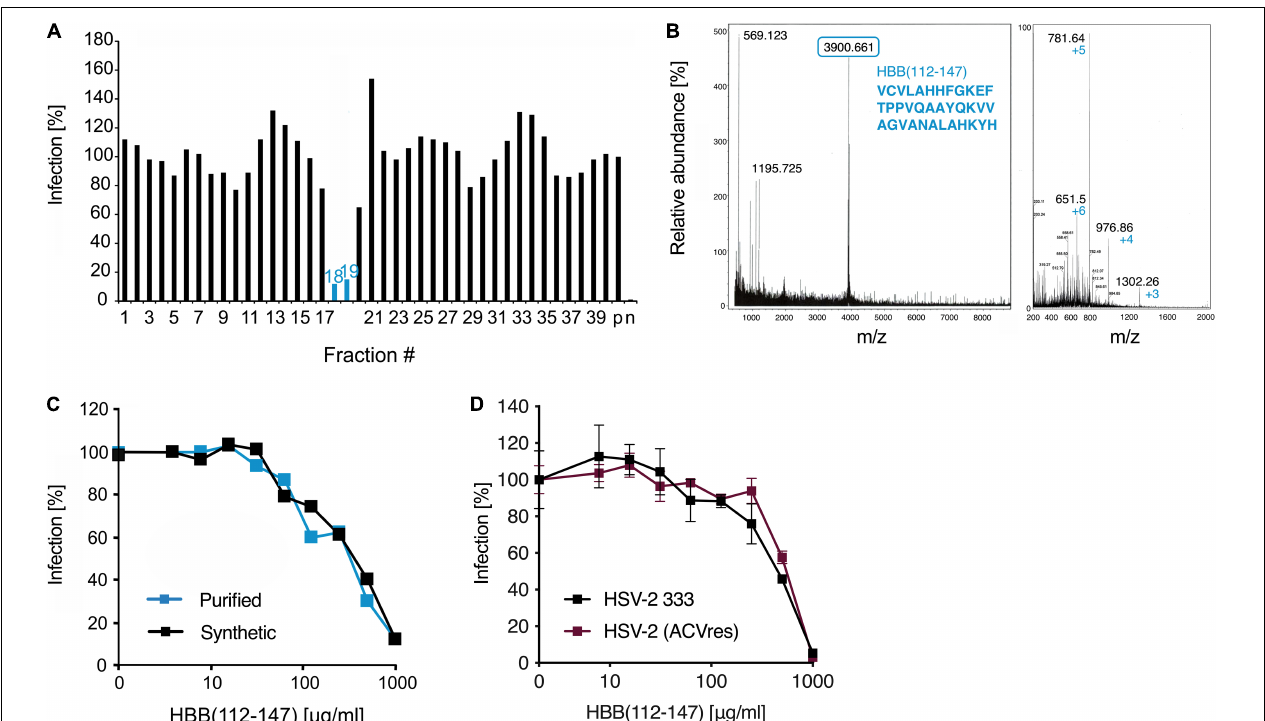
FIGURE 1 | Identification of a C-terminal fragment of hemoglobin as HSV-2 inhibitor in a placenta-derived peptide library. (A) Fractions 1–39 of pH pool 4 of the placenta library were added to ELVIS cells and subsequently infected with HSV-2. Infection rates were determined 2 days later by quantifying β -galactosidase activities in cellular lysates. (B) MALDI-MS (left) and ESI-MS (right) spectra of fraction 19. The peaks correspond to HBB(112–147). (C) HBB(112–147) purified from placenta and chemically synthesized peptide inhibit HSV-2 infection. Peptides were added at indicated concentrations to ELVIS cells, and cells were infected with a clinical HSV-2 isolate. Infection rates were determined 2 days later by quantifying β -galactosidase activities in cellular lysates. (D) Activity of HBB(112–147) against a lab strain of HSV-2 (333) and a clinical, highly ACV-resistant isolate. Peptides were added to ELVIS cells at indicated concentrations and cells were infected after 30 min incubation. Infection rates were determined 24 hpi by quantifying β -galactosidase activity.